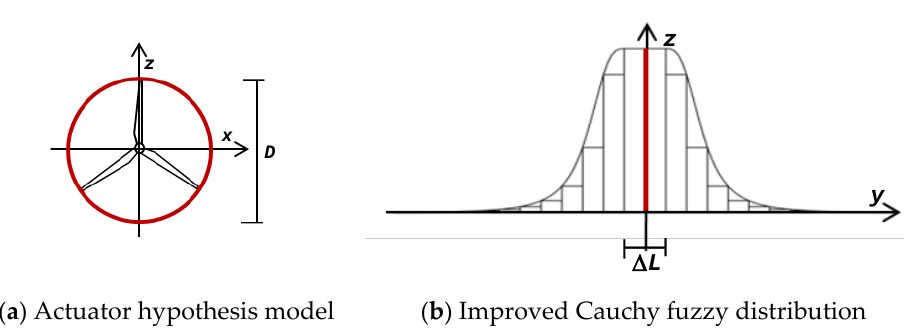
Figure 4. Schematic diagram of the 3D fuzzy model.